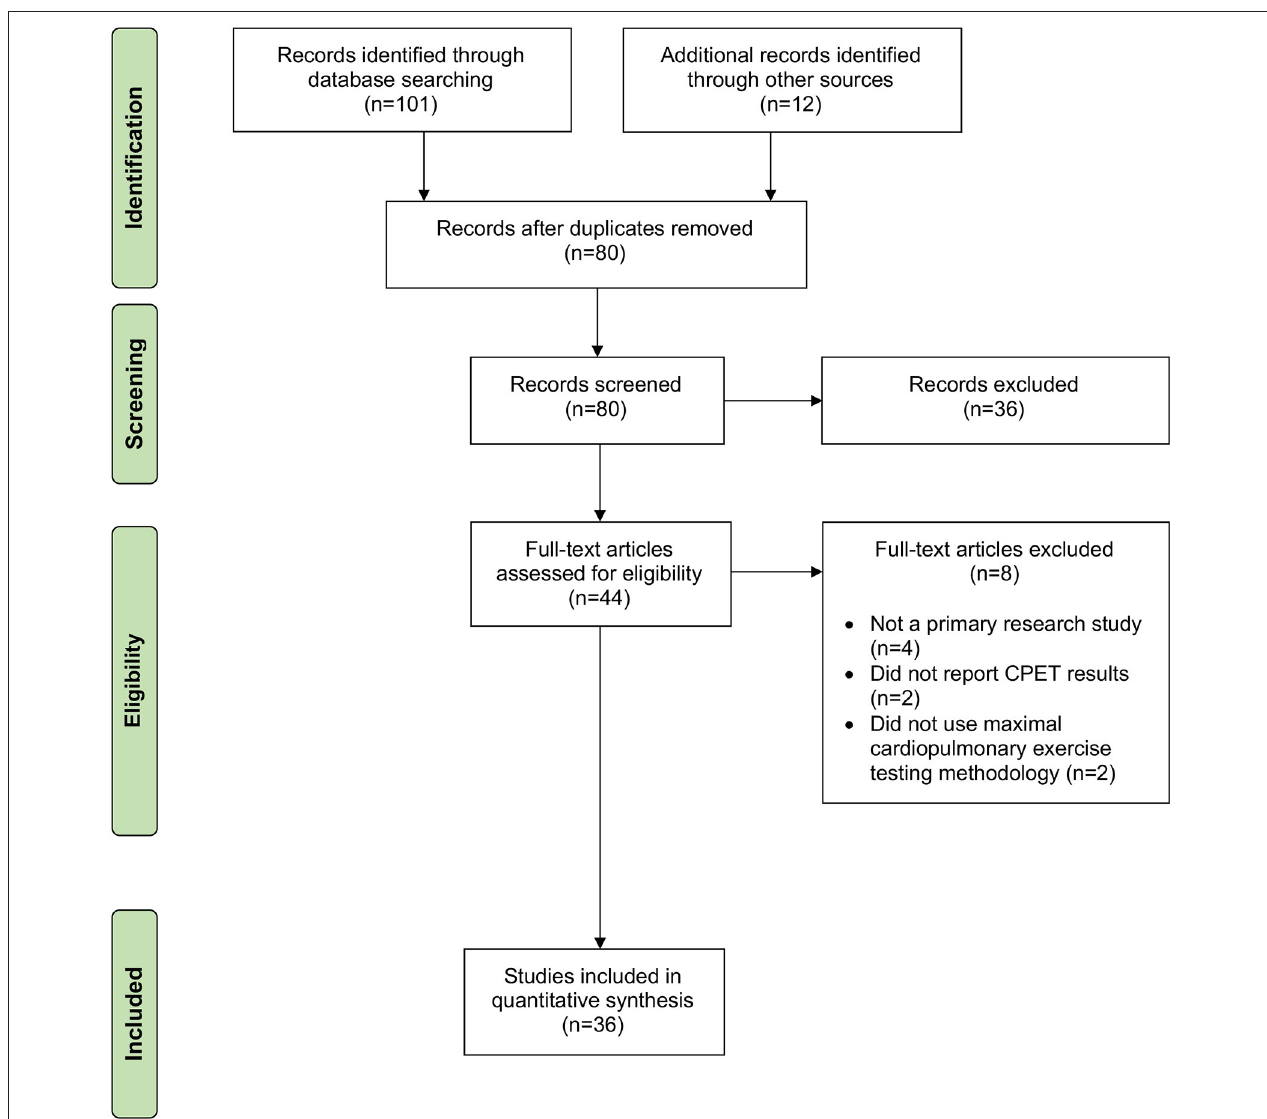
FIGURE 1 | Flow diagram describing the systematic